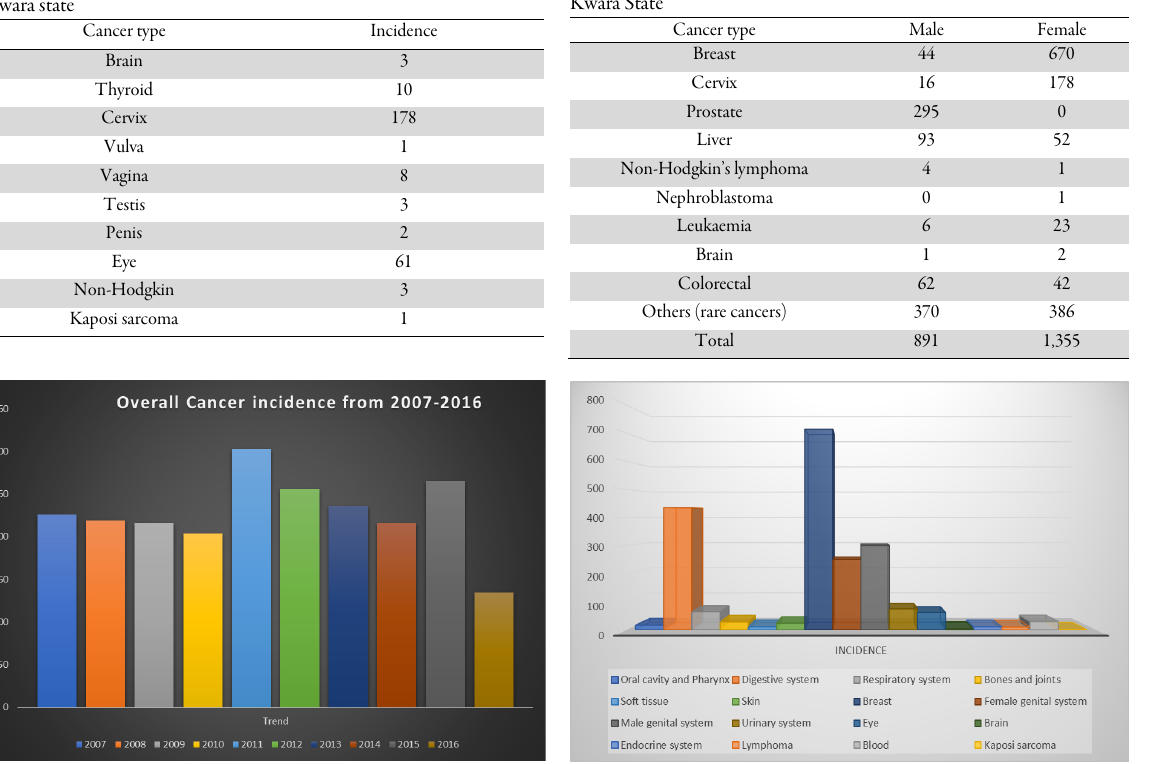
Table 3. Some selected rare cancer groups in Ilorin, Table 4. Gender characteristic of some selected cancer groups in Ilorin,